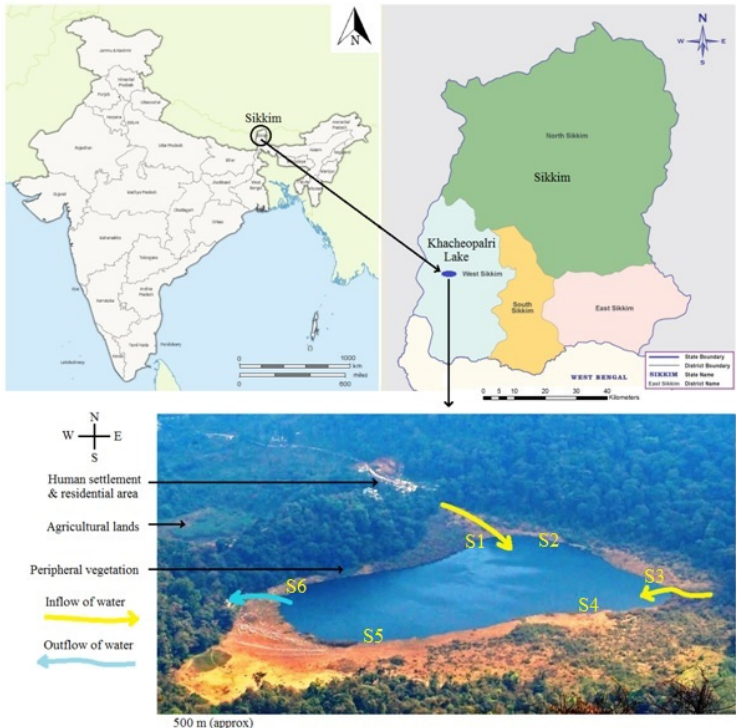
Fig. 1: Geographic location of the study area in eastern Himalaya